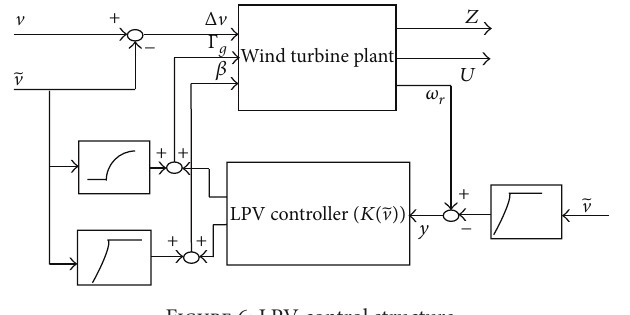
Figure 6: LPV control